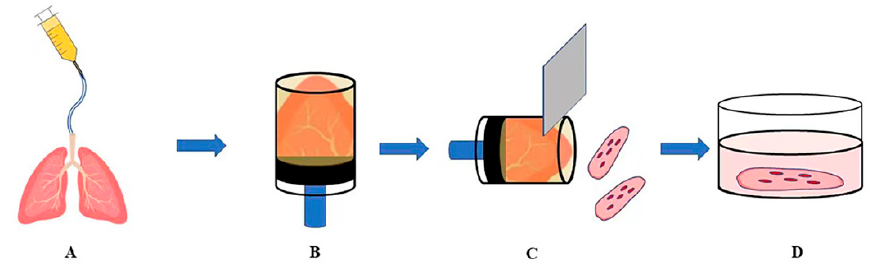
Figure 2. Schematic diagram of a standard preparation of rodent lung slices. ( A ): Fill the lungs with an appropriate volume of 0.5–3% warm agarose solution according to the size of the animal’s lungs to fully inflate the lungs; ( B ): Use a biopsy punch to generate a tissue cylinder with a diameter of 8 mm; ( C ): Use automatic sectioning precise cutting with the machine, usually 100–500 μ m thick; ( D ): Place in serum-free MEM with 50 μ g/mL gentamicin and 0.25 μ g/mL amphotericin at 37 °C, 5% CO 2 incubation under conditions.